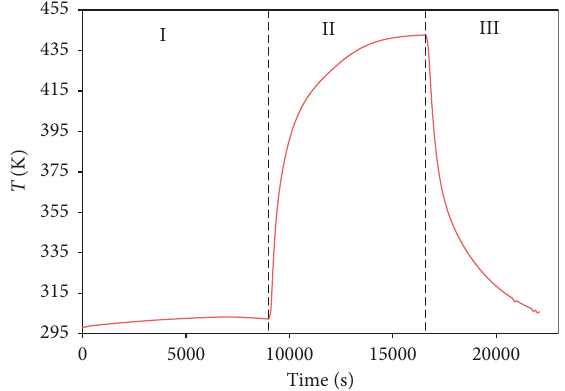
Figure 16: Gas temperature history along the bed during one cycle.